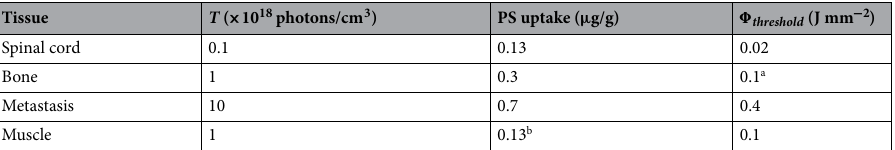
a Estimated based on a preclinical study